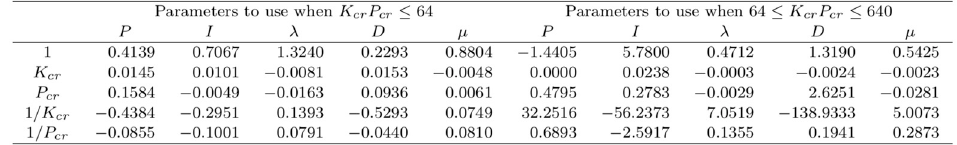
8 of 26 Table 1. FO-PID parameters according to the modified Ziegler-Nichols method and for different values of the fractional order 𝜆 [40]. 𝝀